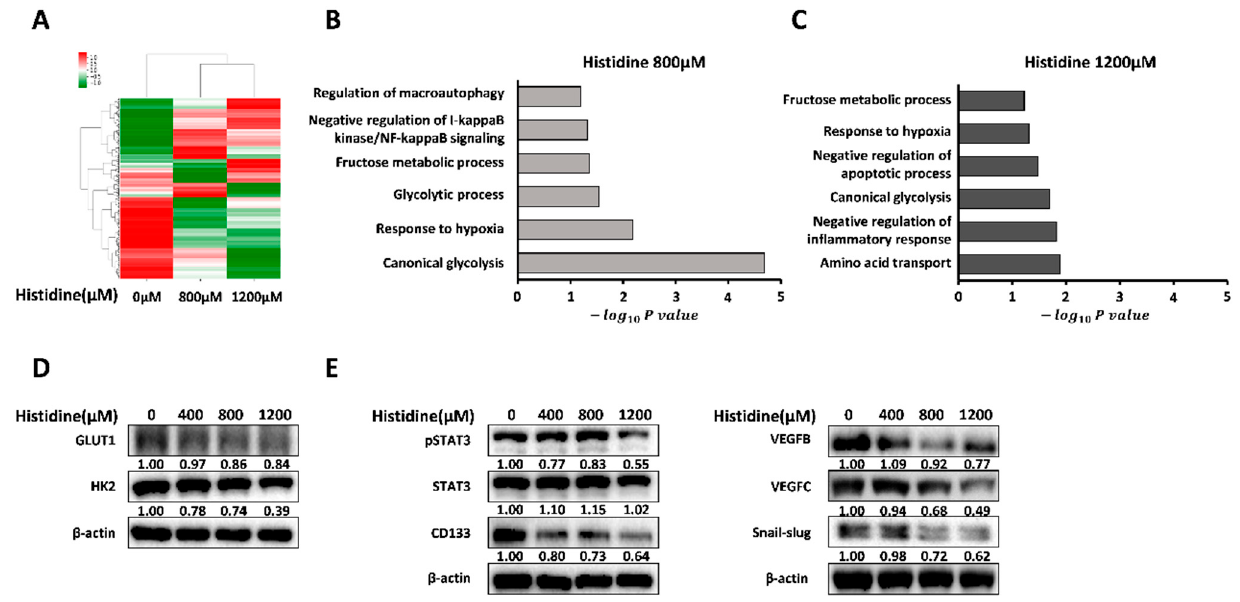
Figure 1. Effect of histidine in HepG2 cells at the gene and protein levels. ( A ) A heatmap of RNA- seq data was generated to show relative transcriptomic differences. Fold change of the indicated genes obtained by gene expression profiling of HepG2 cells after treatment with 0 μ M, 800 μ M, and 1200 μ M histidine in EBSS under hypoxic conditions. ( B , C ) Summary of DAVID functional annota- tion analysis to assess GO enrichment for differentially expressed genes in HepG2 cells after 800 μ M (B) and 1200 μ M (C) versus 0 μ M histidine treatment. ( D ) HepG2 cells were incubated with indi- cated concentrations of histidine in EBSS media under hypoxia (1% oxygen). After 24 h, GLUT1, hexokinase2 (HK2), and β -actin expression levels were examined by Western blotting. The ratios of the band intensities normalized by actin are reported below the respective panels. The presented images are cropped and the whole blot images are presented in Figure S6. Data shown represent one of three independent experiments with similar results. The quantification of band intensities from three independent experiments are shown in Figure S2A,B. ( E ) In the same conditions as in (D), the protein levels of pSTAT3, STAT3, VEGFB, VEGFC, CD133, Snail/slug, and β -actin were an- alyzed by Western blotting. The ratios of the band intensities normalized by actin are reported be- low the respective panels. The presented images are cropped and the whole blot images are pre- sented in Figure S7. Data shown represent one of three independent experiments with similar re- sults. The quantification of band intensities from three independent experiments are shown in Fig- ure S2C–G.